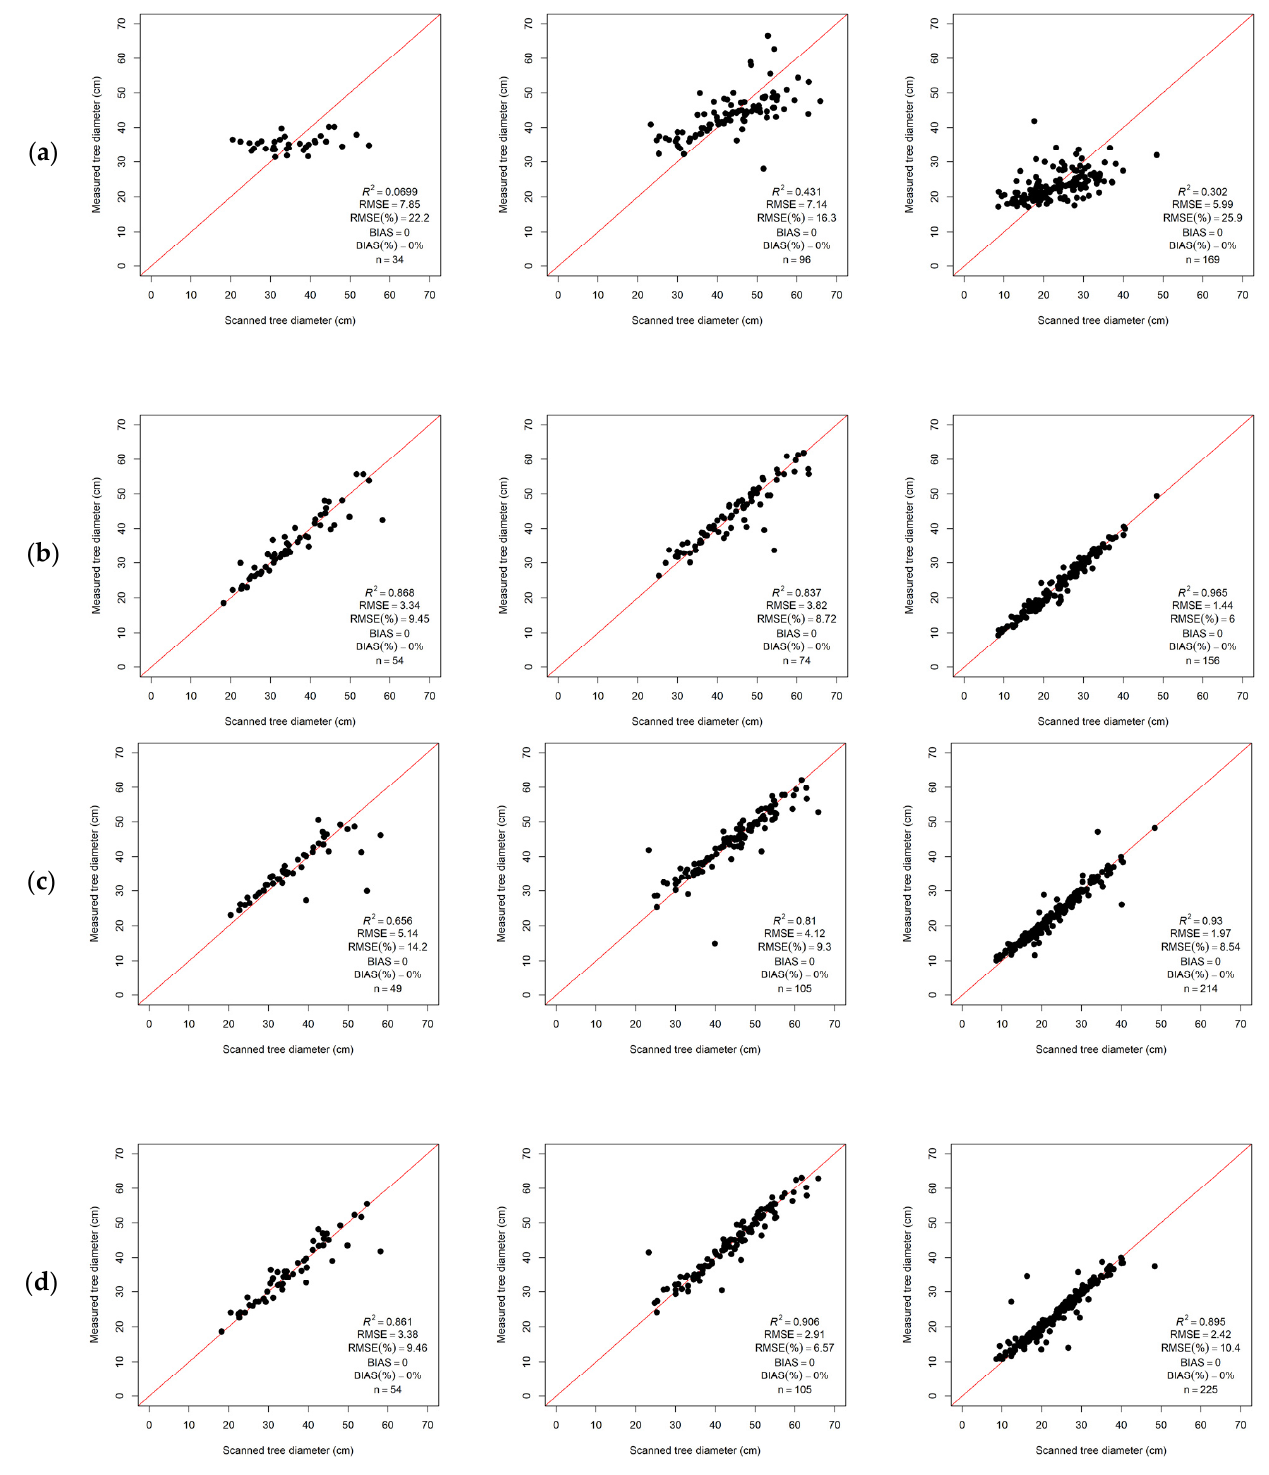
Figure 9. Predicted versus observed diameter at breast height using matching tree pairs. Results are